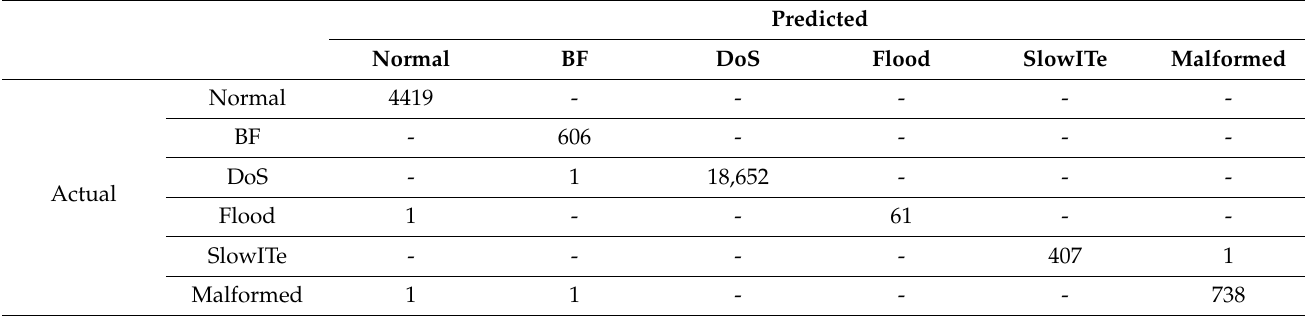
Figure 18. Accuracy when a connection ACK is not used.